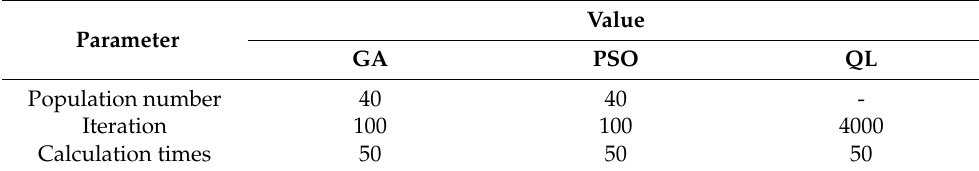
Table 4. The set parameters of the GA, PSO, and QL.